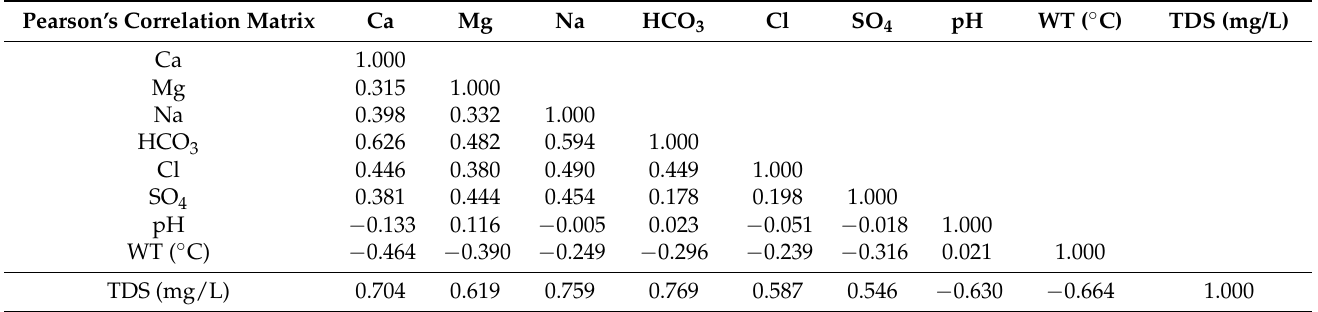
Table 2. Correlation matrix of input variables corresponding to TDS.